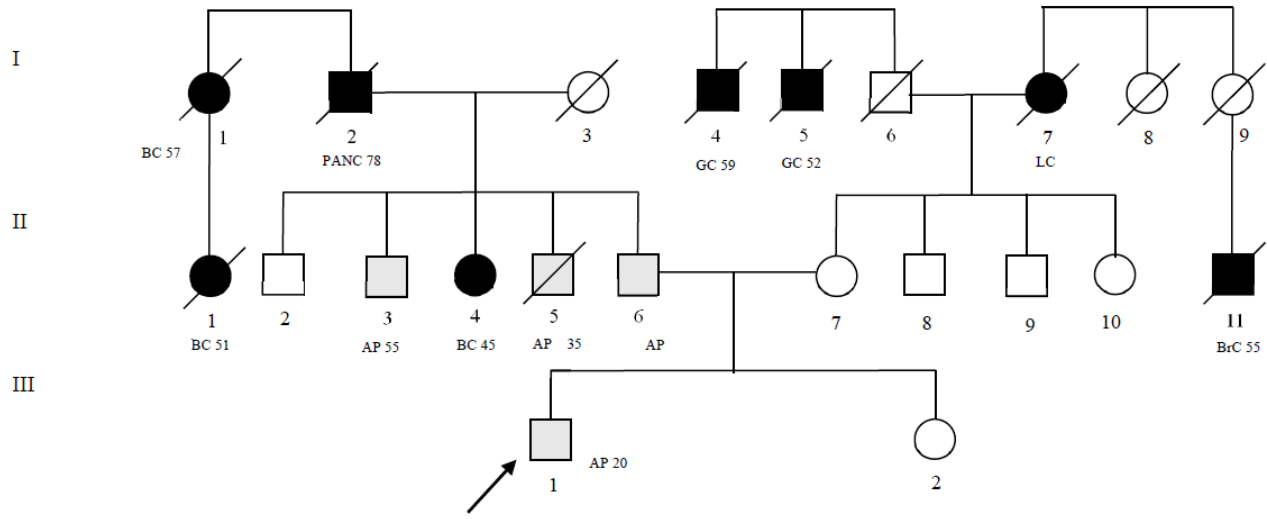
Figure 1. Family pedigree of the patient. The numbers next to each diagnosis denote the age at onset. Symbols and abbreviations used are denoted as follows: arrow, index case (proband); symbols with diagonal lines, succumbed; black symbol, CRC or tumors associated with Lynch syndrome; gray symbol, pre-cancerous lesions; CRC, colorectal cancer; LC, lung cancer; PANC, pancreatic cancer; BC, breast cancer; GC, gastric cancer; BrC, brain cancer; AP, adenomatous polyp; squares, males; circles, females. I – II – III generation.